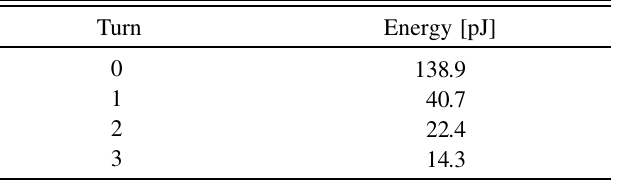
TABLE I. Energy per pulse of the CSR at the bending magnet of the IR beam line for several turns after slicing.